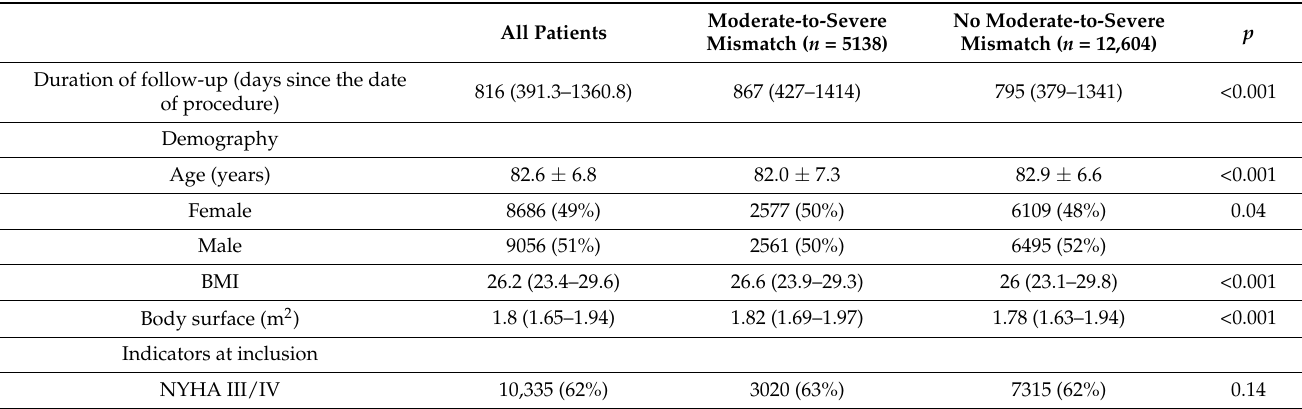
Table 1. Baseline and postimplantation characteristics (PPM